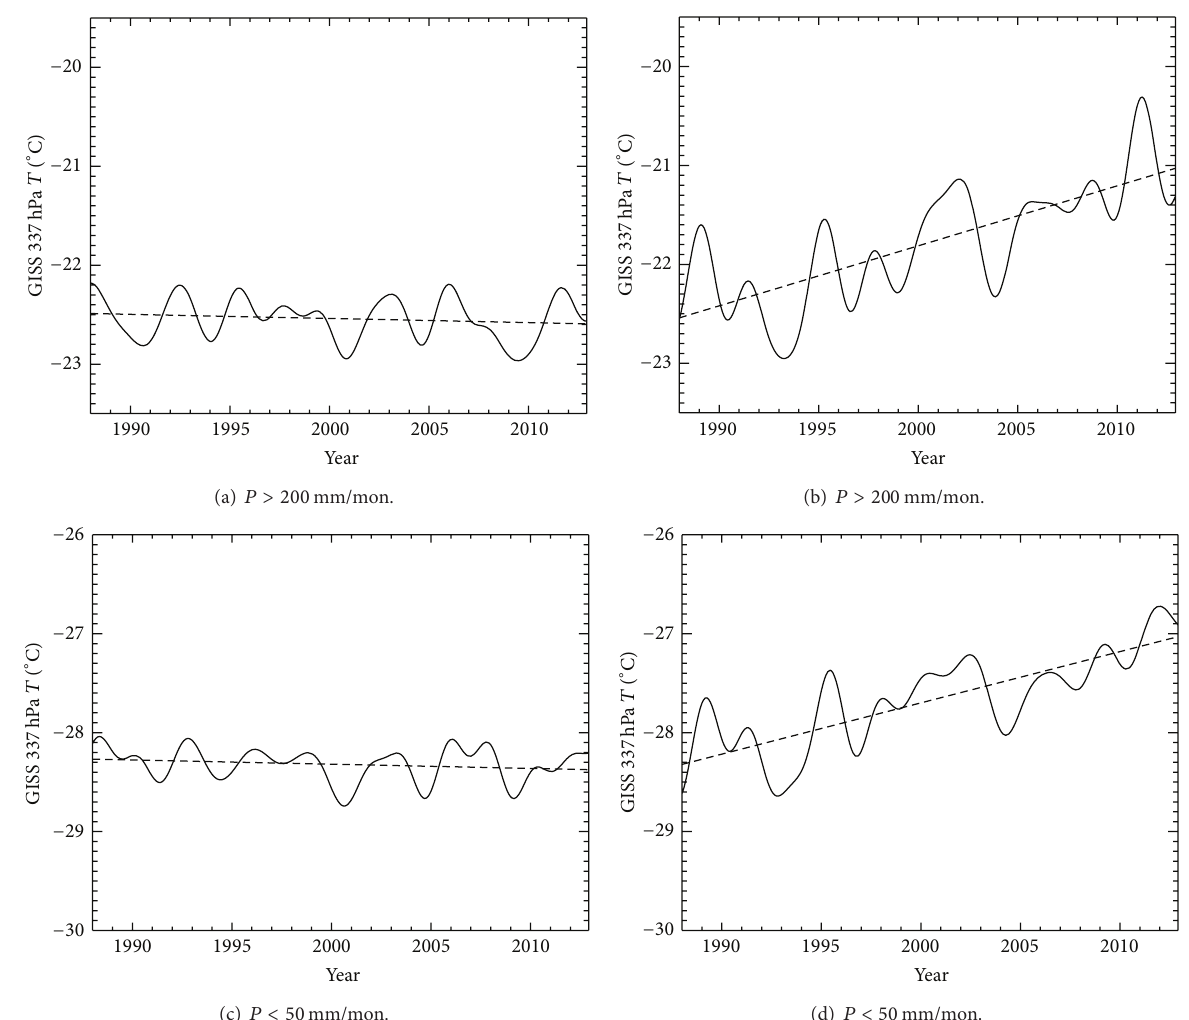
Figure 4: Low-pass filtered time series for 337 hPa temperature ( 𝑇 ) from GISS/HYCOM. (a) 𝑇 over high-precipitation area ( 𝑃 > 200 mm/mon.)fromthecontrolsimulation(solidline)andtrend(dashedline).(b) 𝑇 overhigh-precipitationareafromthehistoricsimulation (solid line) and trend (dashed line). (c) Same as (a) except for areas with precipitation < 50mm/mon. (d) Same as (b) except for areas with precipitation < 50